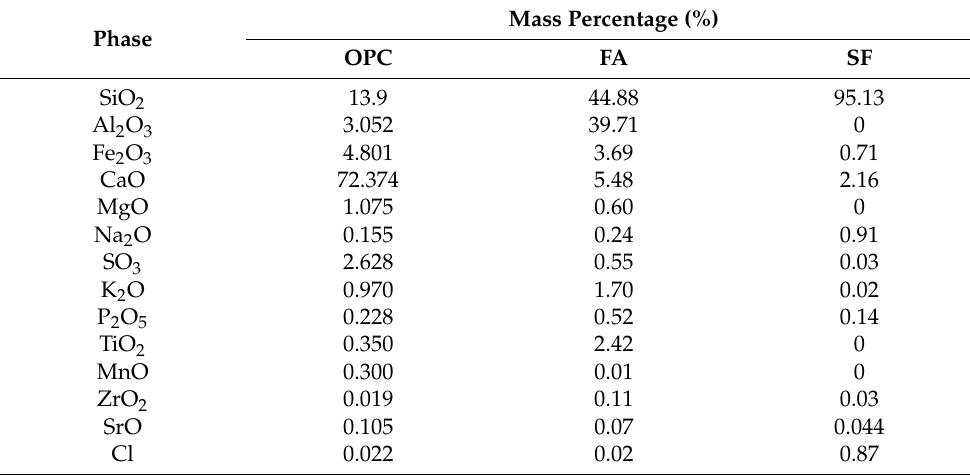
Table 1. Chemical compositions of OPC, FA, and SF used in the